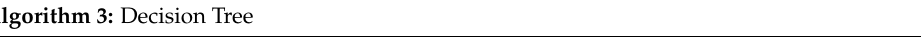
Algorithm 3: Decision Tree